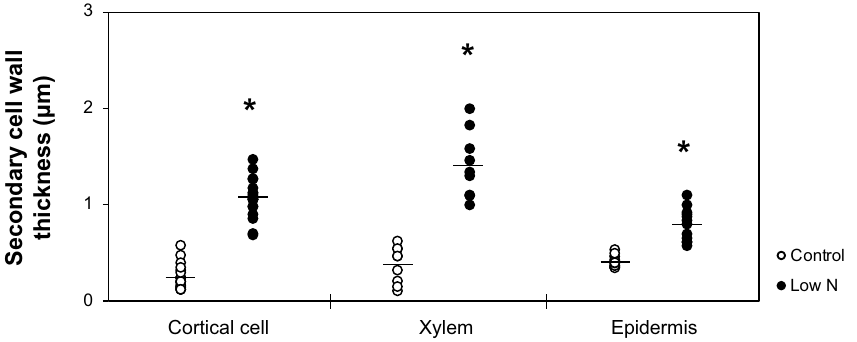
Figure 6. Cell wall thicknesses of cortical, xylem, and epidermal cells of hydroponically-grown sorghum seedlings cultivated under control or low-N conditions at 3 weeks after treatment. Points indicate each measured value; 18 measurements from 6 individual cells for cortical cells, 9 measurements from 3 individual cells for xylem, and 12 measurements from 4 individual cells for epidermal cells. Horizontal bars indicate the averages. Asterisks indicate significant differences between controls and low-N plants (Student’s t test, p <